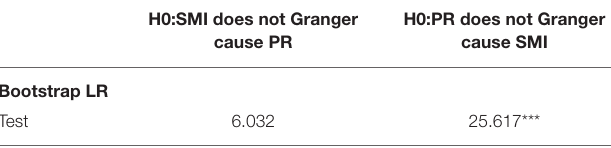
TABLE 2 | Full-sample Granger causality tests.